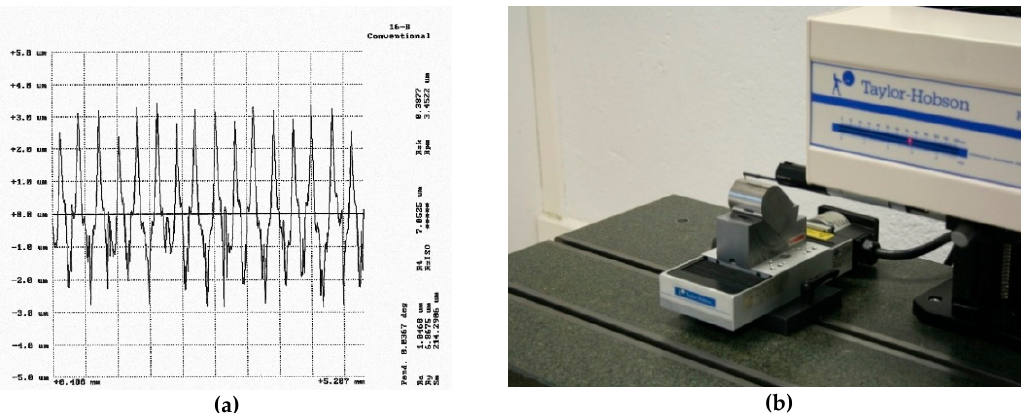
Figure 4. ( a ) Example of roughness profile; ( b ) Taylor-Hobson Form Taylsurf Series 2 profile roughness tester.